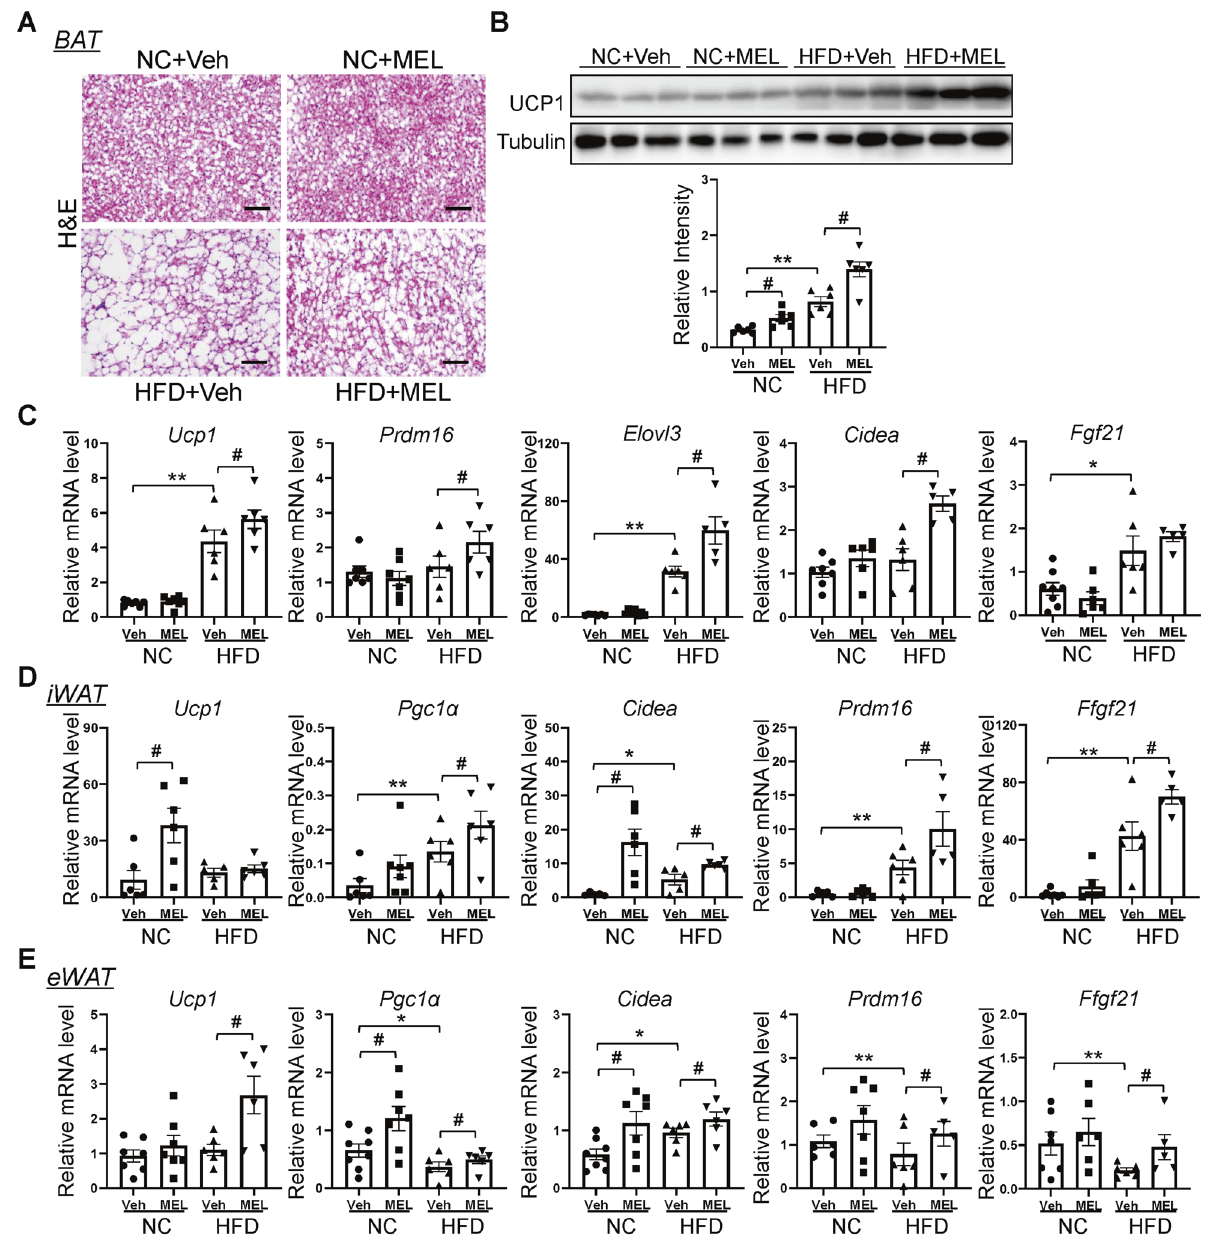
Fig. 3 Melatonin increases UCP1 expression in BAT and WAT of HFD-stimulated mice. A H&E-stained BAT sections of NC-fed and HFD-fed mice. Scale bars = 100 μ m. B Immunoblots of UCP1 in BAT of NC-fed and HFD-fed mice. C mRNA expression of thermogenesis-related genes in BAT of NC-fed and HFD-fed mice. D , E mRNA expression of beige-related genes in iWAT ( D ) and eWAT ( E ) of NC-fed and HFD-fed mice. Data are mean ± SEM, n = 5 – 8. Signi fi cance was determined by one-way ANOVA. *p < 0.05, **p < 0.01 vs. NC + Veh mice; # p < 0.05, ## p < 0.01, vs. HFD + Veh